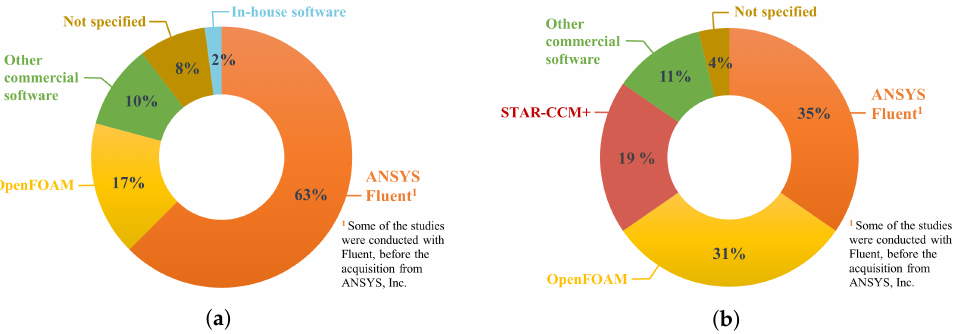
Figure 6. Software usage by publication type. ( a ) Research publications; ( b ) Applied